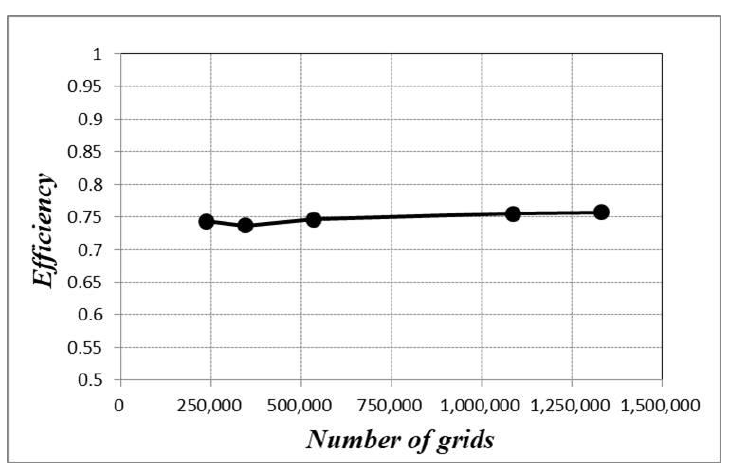
Figure 6. Grid independence test for the numerical analysis.